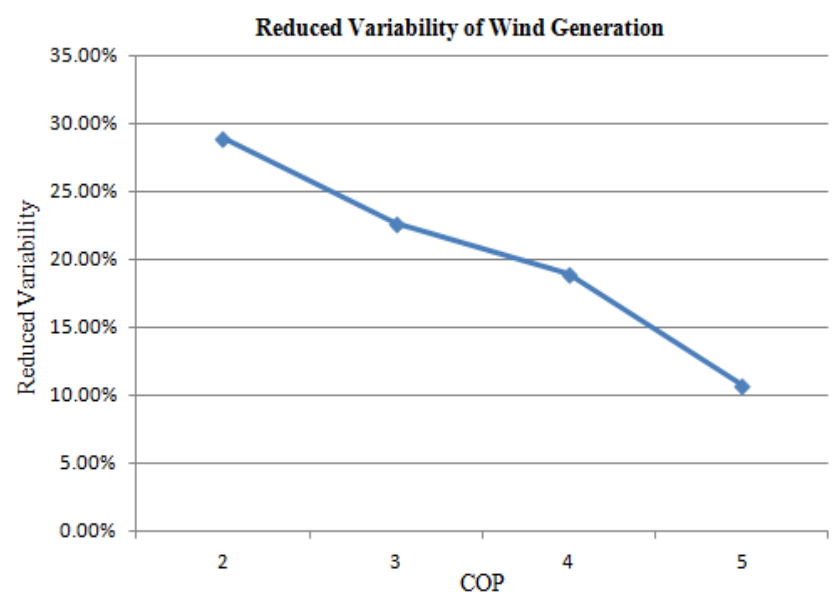
Figure 2. Reduced Variability of Wind Power.